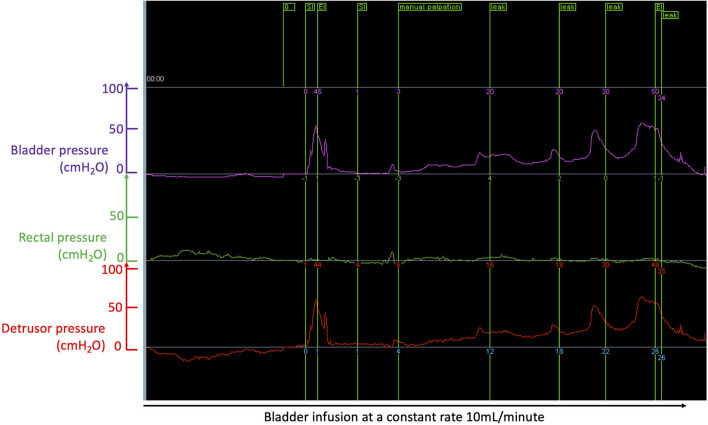
Cystometry curves recorded during bladder filling at a constant rate of 10 mL/min with a dual lumen catheter placed in the bladder through the urethra; the purple trace shows bladder pressure; the green trace shows rectal pressure measured from a rectal balloon; the red trace is the “true” bladder pressure or “detrusor” pressure obtaining by subtracting the bladder pressure (purple curve) by the rectal pressure (green trace): this allows correction for increase bladder pressure peaks due to increase in abdominal pressure, e.g., when the dog moves or barks. In this example of a dog with chronic severe T3-L3 spinal cord injury (causing paraplegia and incontinence), one can see a peak of pressure corresponding to manual palpation by the clinician (green flag at the top “manual palpation” used as a test control); the first peak of pressure to the left of the recording is an artifact; further to the right, involuntary peaks of pressure are recorded and flagged (see green flags at the top “leak”) and lead to involuntary emission of urine (i.e., incontinence); during filling, the detrusor pressure slowly rises (here to pressure >50 cmH2O); however, full voluntary emptying should occur in normal animals when the detrusor pressure reaches ~20 mH2O and this has not happened here.